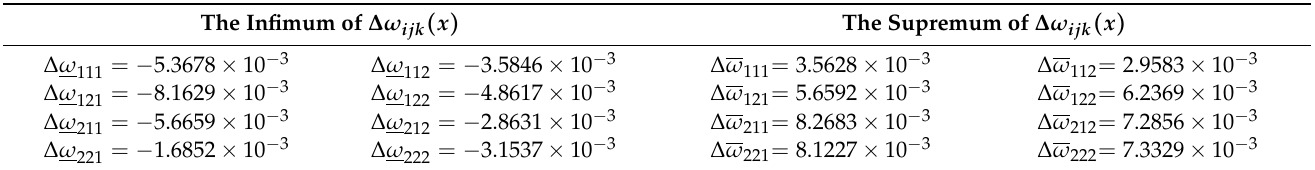
Table 2. The infimum and supremum of ∆ ω ijk ( x ) with ϑ = 20. The Infimum of ∆ ω ijk ( x ) The Supremum of ∆ ω ijk ( x